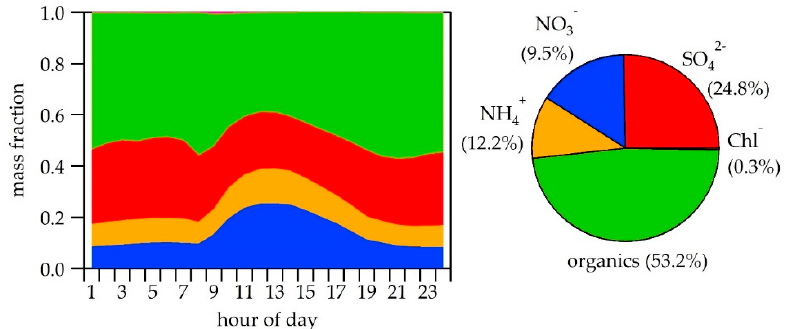
Figure 3. Average mass fraction diurnal profile and average percent composition of NR-PM 1 as determined by the Aerosol Chemical Speciation Monitor (ACSM) during ACU15.